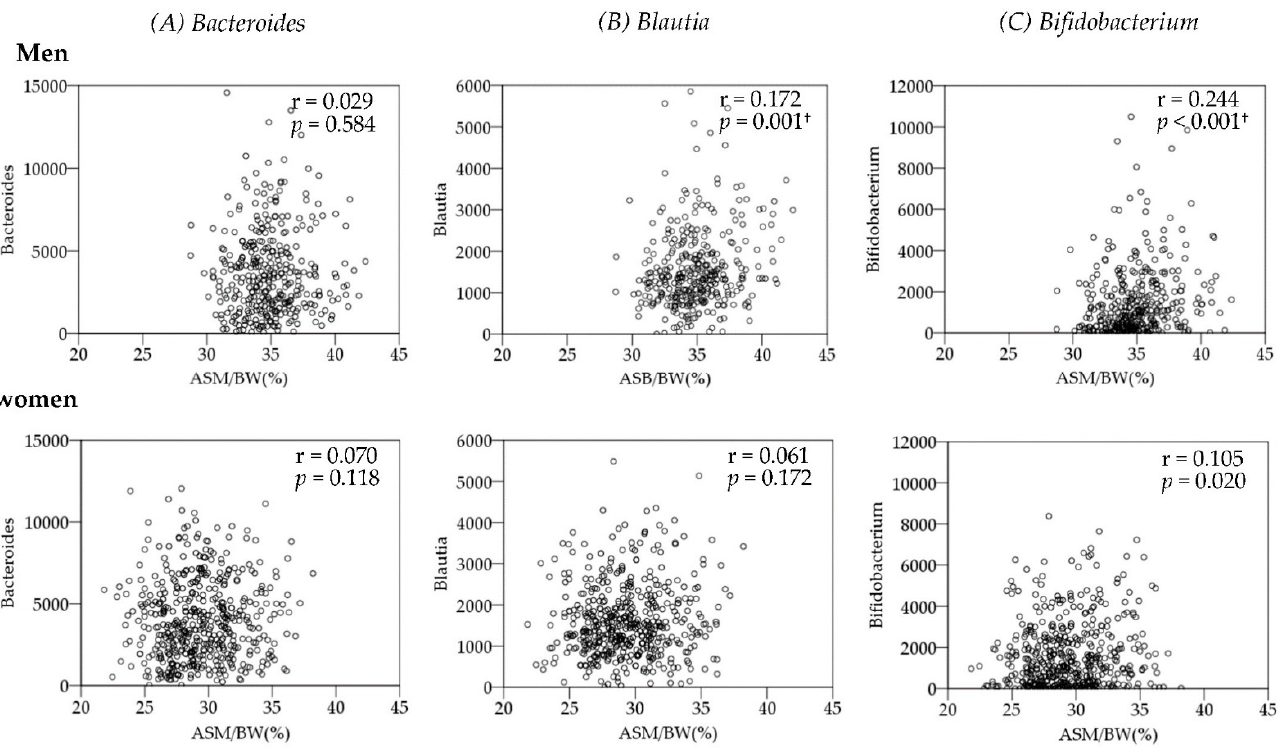
Table 3. Spearman’s correlation between gut microbiota and body composition.